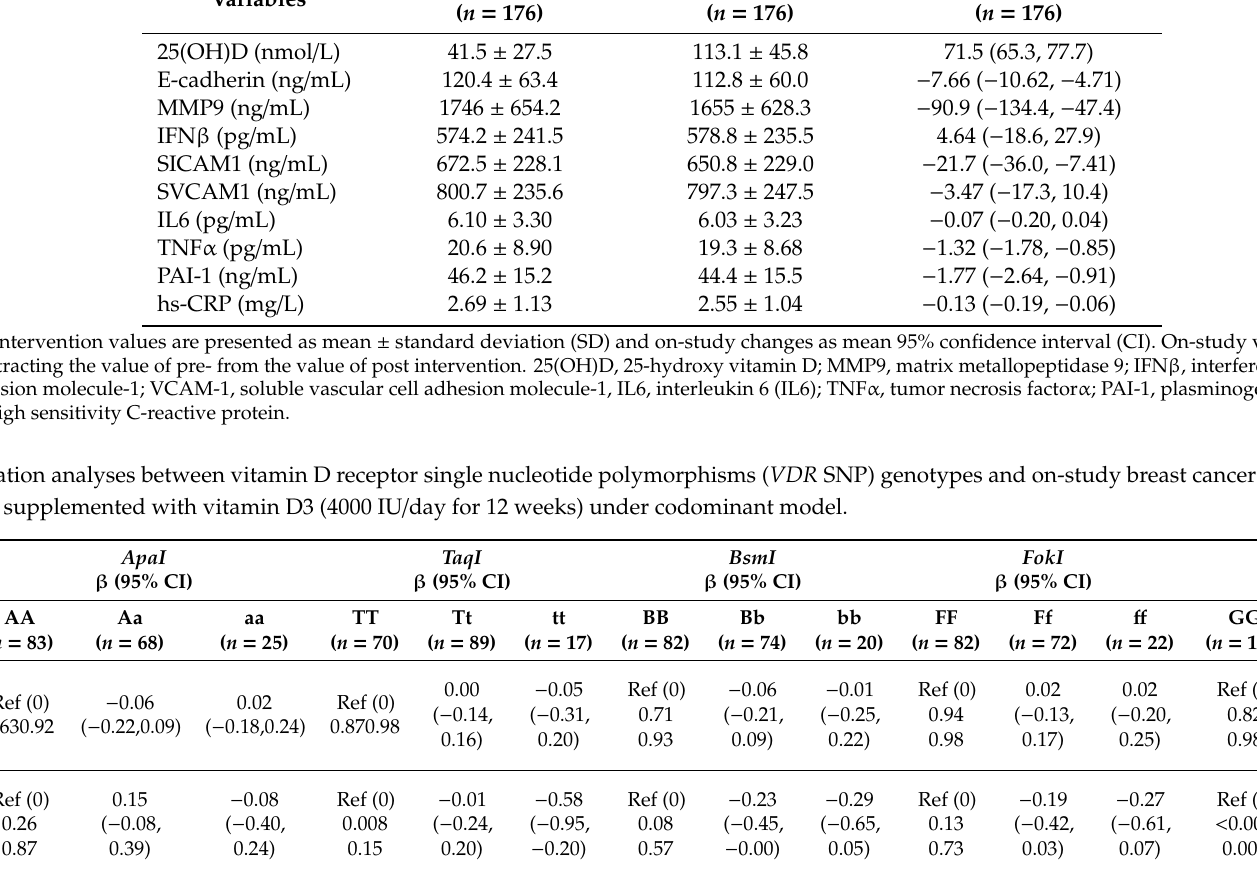
Table 2. Comparison of changes in response variables before and after vitamin D3 supplementation (4000 IU / day) for 12 weeks. Before Intervention After Intervention On-Study Changes Variables ( n = 176) ( n = 176) ( n = 176) 25(OH)D (nmol / L) 41.5 ± 27.5 113.1 ± 45.8 71.5 (65.3, 77.7) E-cadherin (ng / mL) 120.4 ± 63.4 112.8 ± 60.0 − 7.66 ( − 10.62, − 4.71) MMP9 (ng / mL) 1746 ± 654.2 1655 ± 628.3 − 90.9 ( − 134.4, − 47.4)